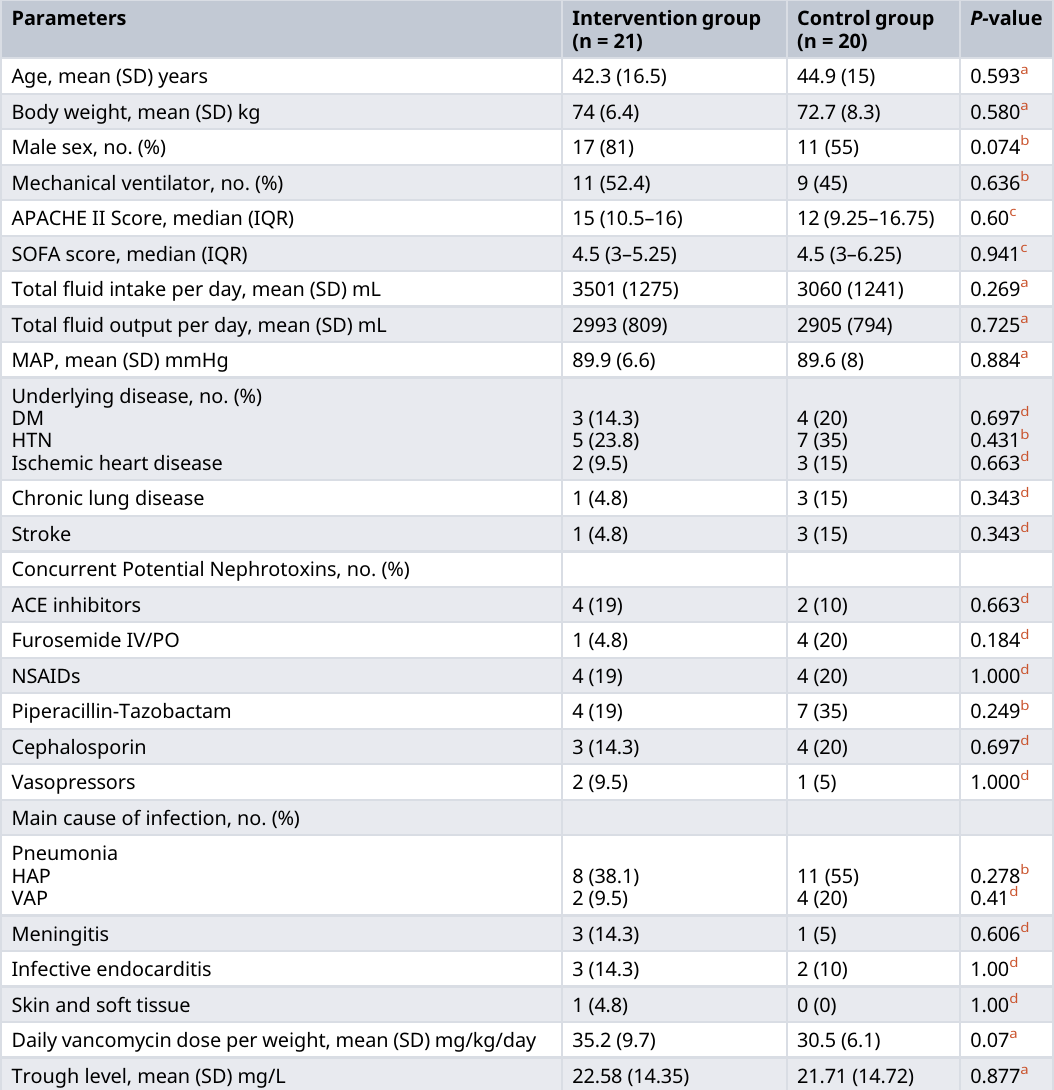
Table1.Patients ’ demographicdata,underlyingdiseasesandconcurrentpotentialnephrotoxinsinthestudy